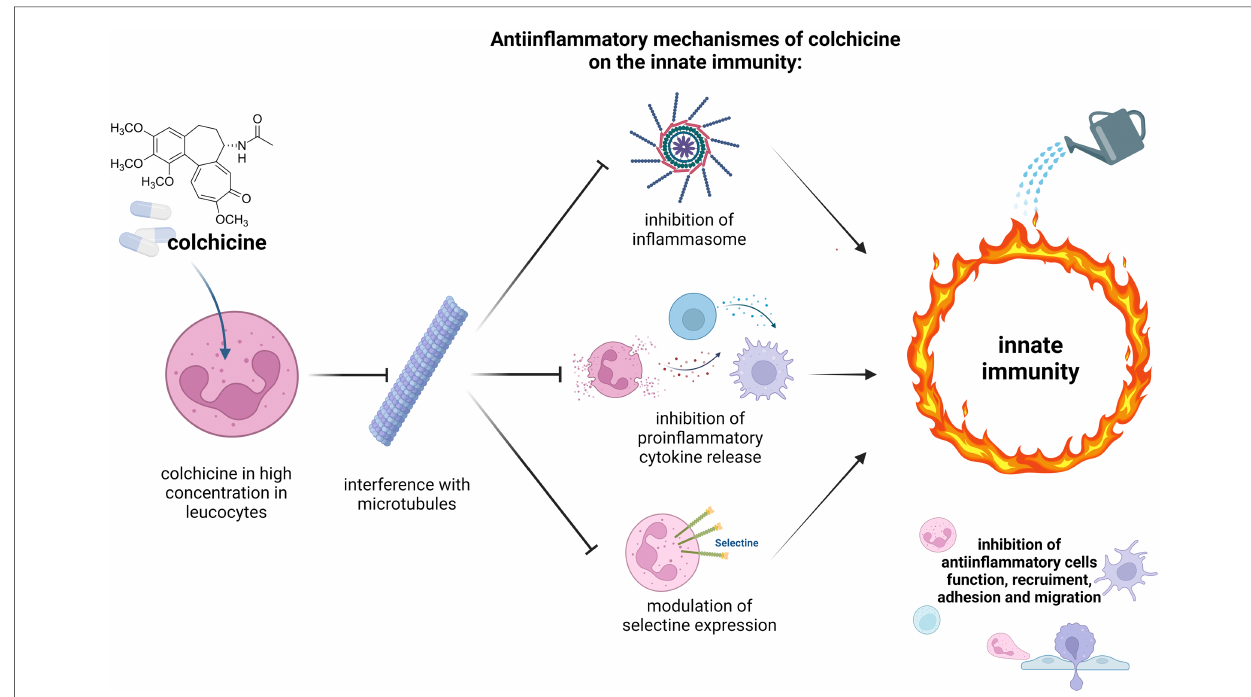
FIGURE 3 Mechanisms of action of colchicine on the innate immunity. High cytoplasmic concentration of colchicine especially in neutrophils are reached because of physiological reduced expression of transport P-glycoprotein (P-gp), which usually excretes drugs out of the cells. Colchicine inhibits assembly and attachment of microtubules. Consequently, several mechanisms of anti-in fl ammatory cell of the innate immunity are inhibited: in fl ammasome, a cytosolic multiprotein oligomers complex, which should activate an in fl ammatory cascade; release of proin fl ammatory cytokines (such as IL-1- β and IL-18) are downregulated; the expression E- and L-selectine on neutrophil surface, which promote the adhesion and the migration of those cells, are inhibited. This complex and sophisticated model results into inhibition of anti-in fl ammatory cells functions, recruitment, and motility of the innate immunity (22, 23, 25) ( fi gure created with